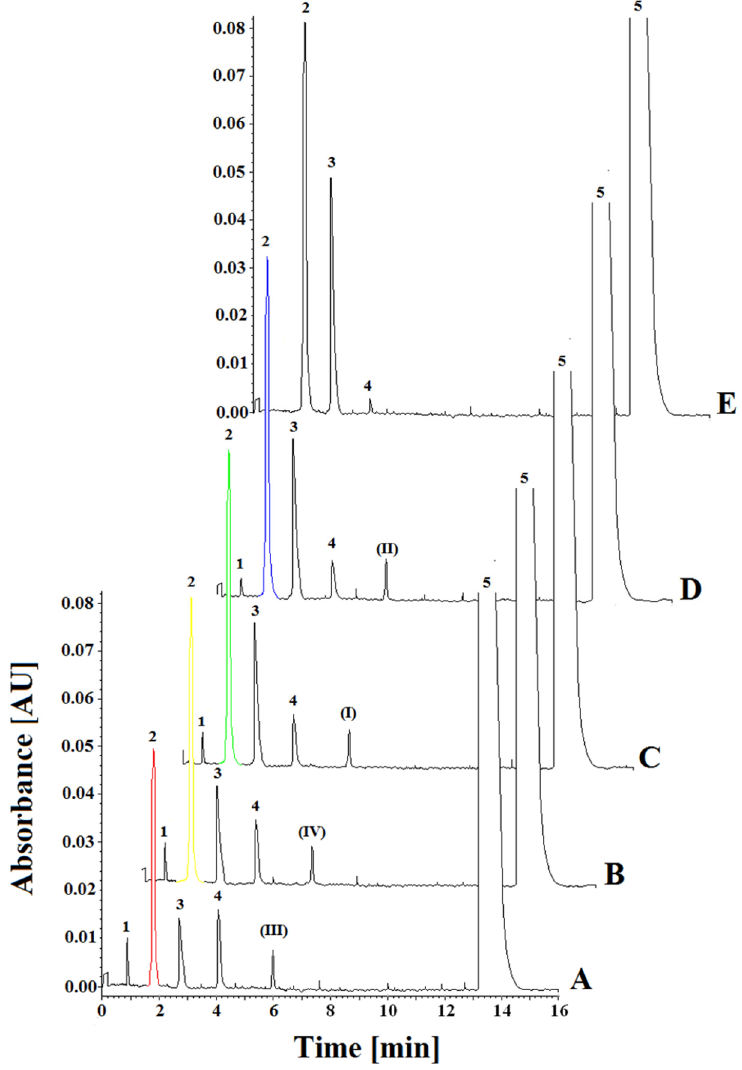
Figure 3. Representative electrophoregrams of investigated compounds in the presence of ( I ), ( II ), ( III ) and ( IV ) AChE inhibitors at the concentration of 0.08 mM and (1) 1.44 mM of acetylthiocholine (ACth), (2) 4,4-dithio-bis-acid nitrobenzoic (DBAN), (3) 5-thio-2-nitrobenzoic acid (NTB), (4) 5,5 ′ - dithio-bis-2-nitrobenzoic acid (DTNB), (5) acetylcholinesterase (AChE). ( A ): (2) 0.41 mM of 4,4-dithio- bis-acid nitrobenzoic (DBAN) in the presence of inhibitor ( III ). ( B ): (2) 0.48 mM of 4,4-dithio-bis-acid nitrobenzoic (DBAN) in the presence of inhibitor ( IV ). ( C ): (2) 0.52 mM of 4,4-dithio-bis-acid nitroben- zoic (DBAN) in the presence of inhibitor ( I ). ( D ): (2) 0.58 mM of 4,4-dithio-bis-acid nitrobenzoic (DBAN) in the presence of inhibitor ( II ). ( E ): (2) 0.66 mM of 4,4-dithio-bis-acid nitrobenzoic (DBAN) without inhibitors.